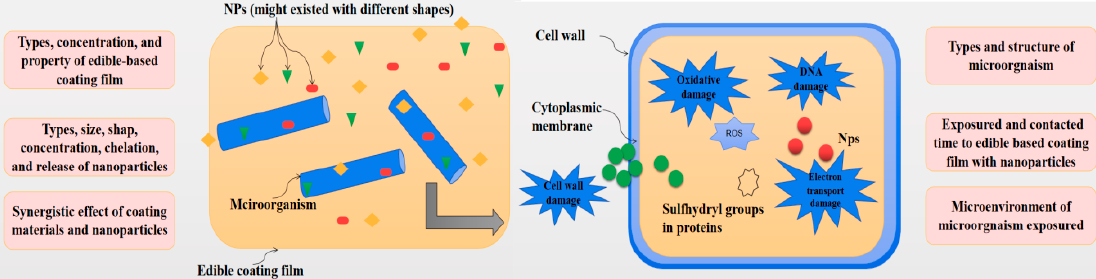
Figure 4. Factors affected the antimicrobial activity of ECF with NPs. Figure 4. Factors a ff ected the antimicrobial activity of ECF with